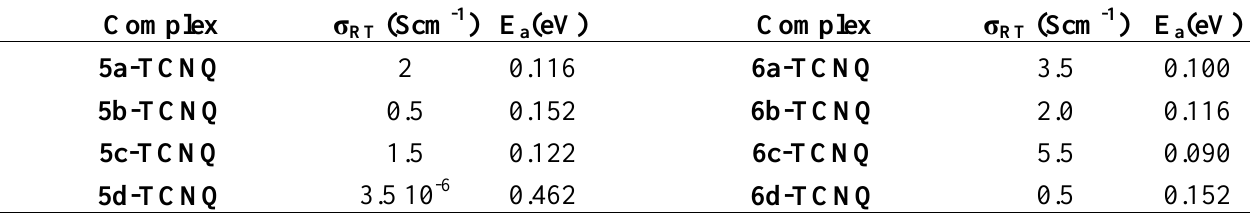
Table 2. Electrical conductivity and activation energies of charge transfer complexes.